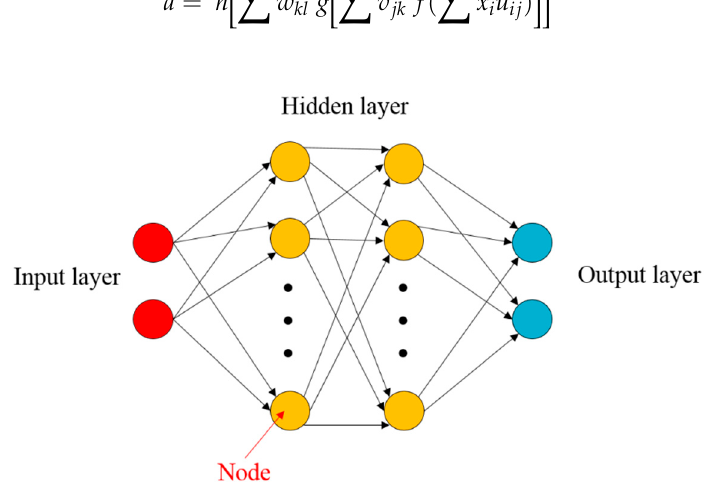
Figure 13. Schematic view of the artificial neural network.